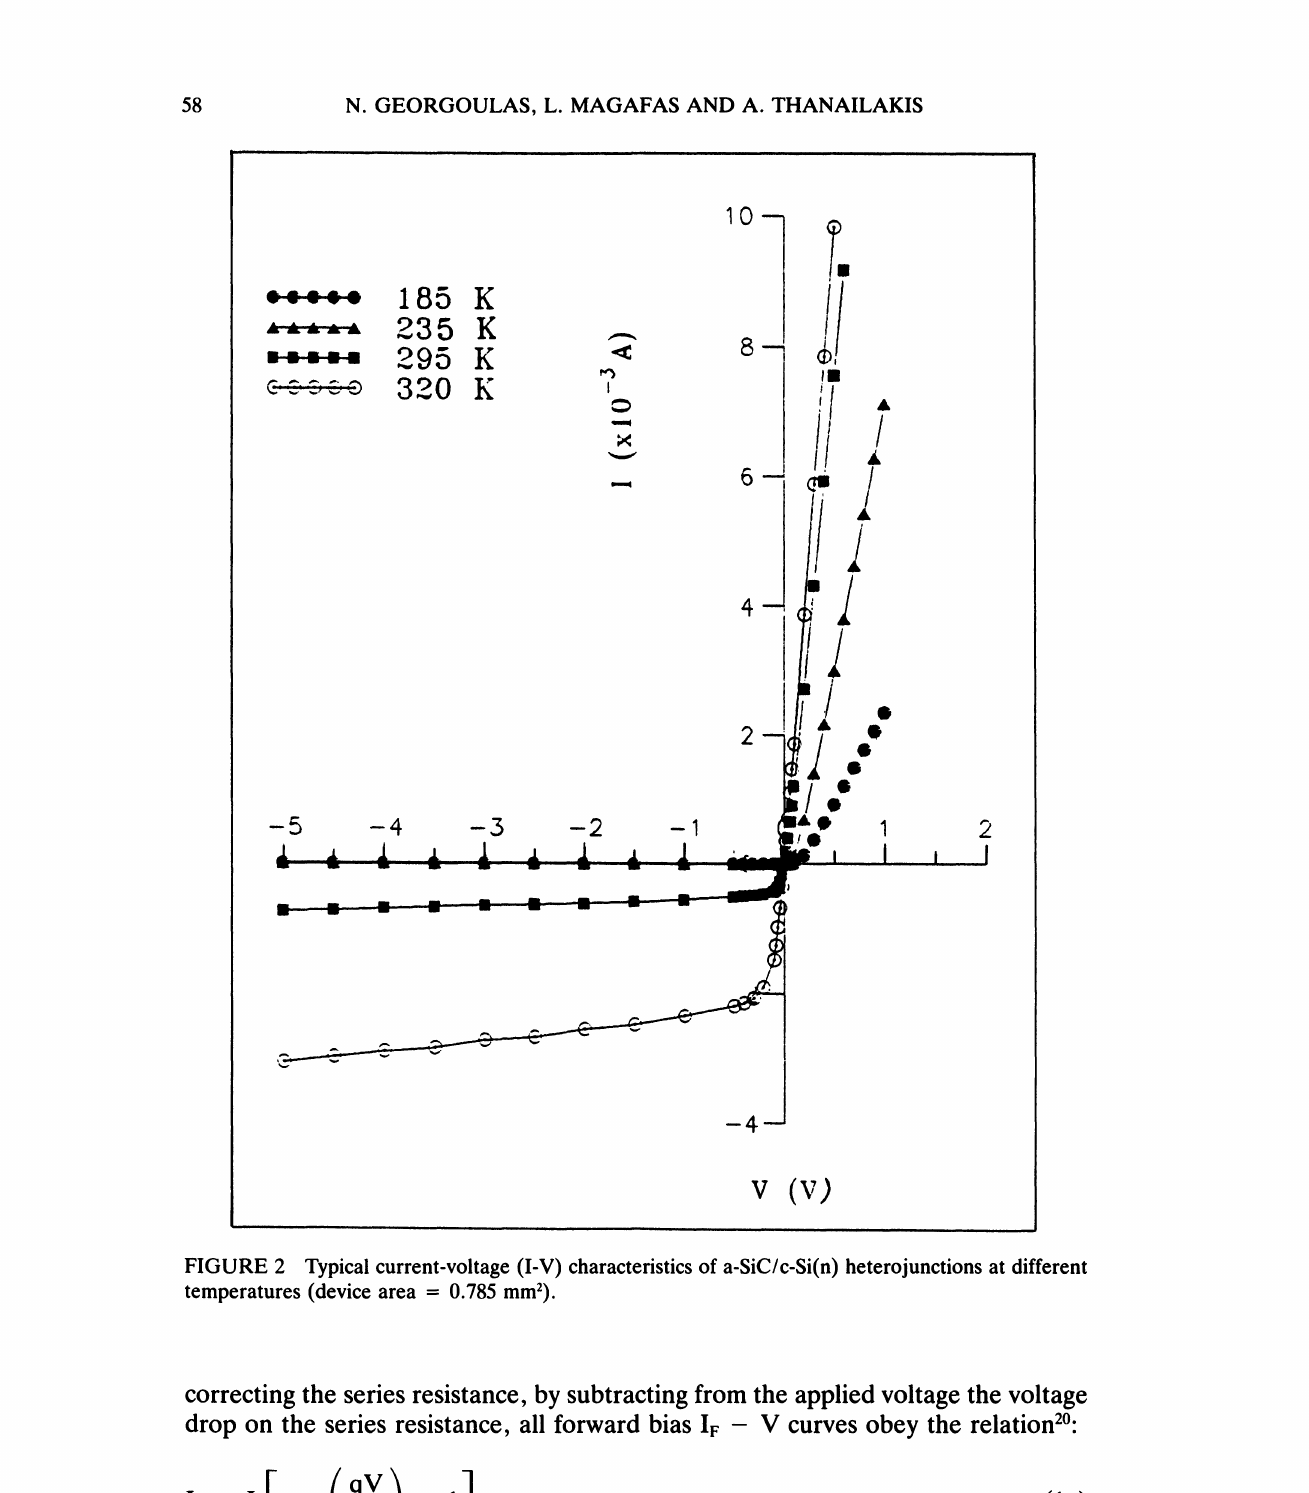
FIGURE 2 Typical current-voltage (I-V) characteristics of a-SiC/c-Si(n) heterojunctions at different temperatures (device area 0.785